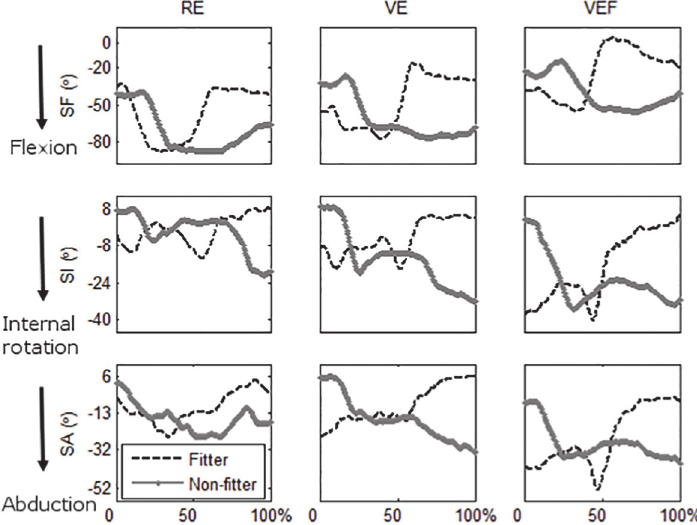
Fig 2. An example of the shoulder flexion (SF), internal rotation (SI) and abduction (SA) angle across a 0 to 100% timeline of a cycle for “ fitter ” (dashed black) and “ non-fitter ” (solid gray) objects and “ Real ” (RE), “ Virtual ” (VE) and “ Virtual with force feedback ” (VEF) platforms. For “ fitter ” objects, the task requires consecutive shoulder flexion and extension to grasp an object and bring it down to pass it through the work panel. The shoulder flexion and extension were concomitant with a short burst of internal rotation and the shoulder was kept adducted while the object was passed through the work panel. For “ non-fitter ” objects, the shoulder was flexed to grasp an object and then it was kept flexed until the object was laid on the disposal shelf. The shoulder was internally rotated and abducted during approaching and after grasping the